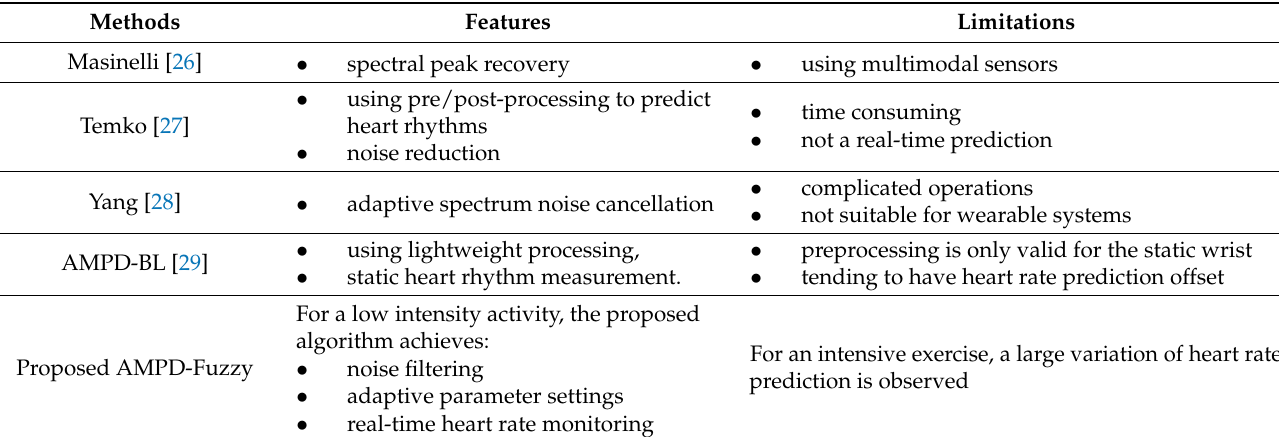
Table 1. The performance comparison: features and